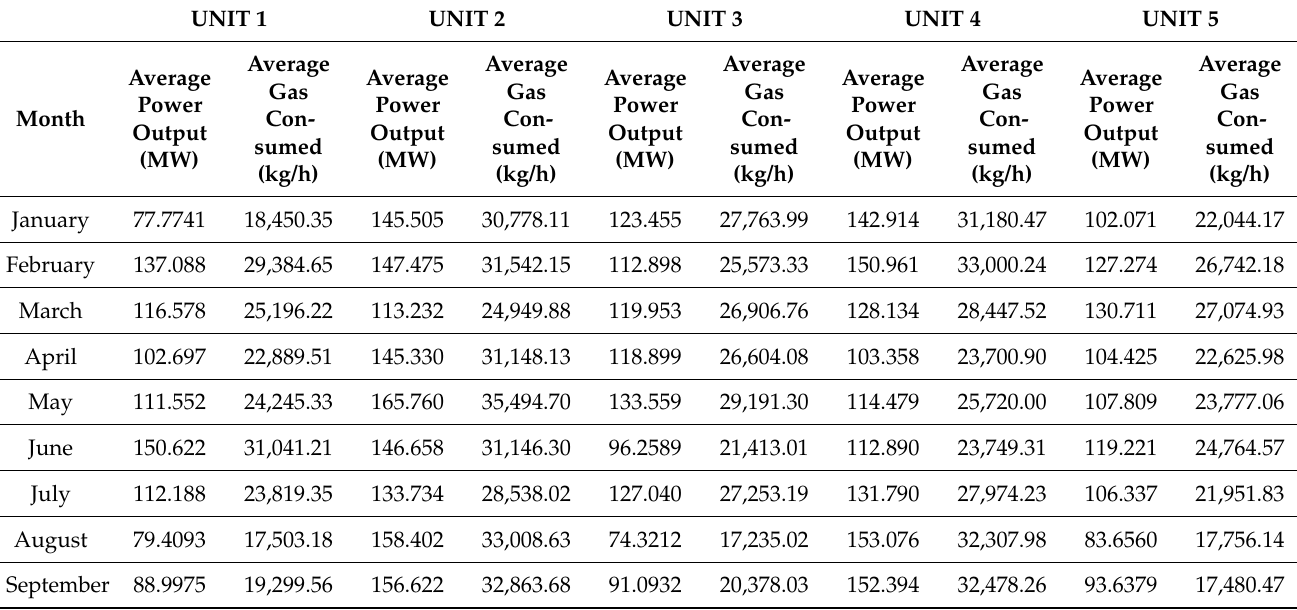
Table 2. Historical power generation data for Units